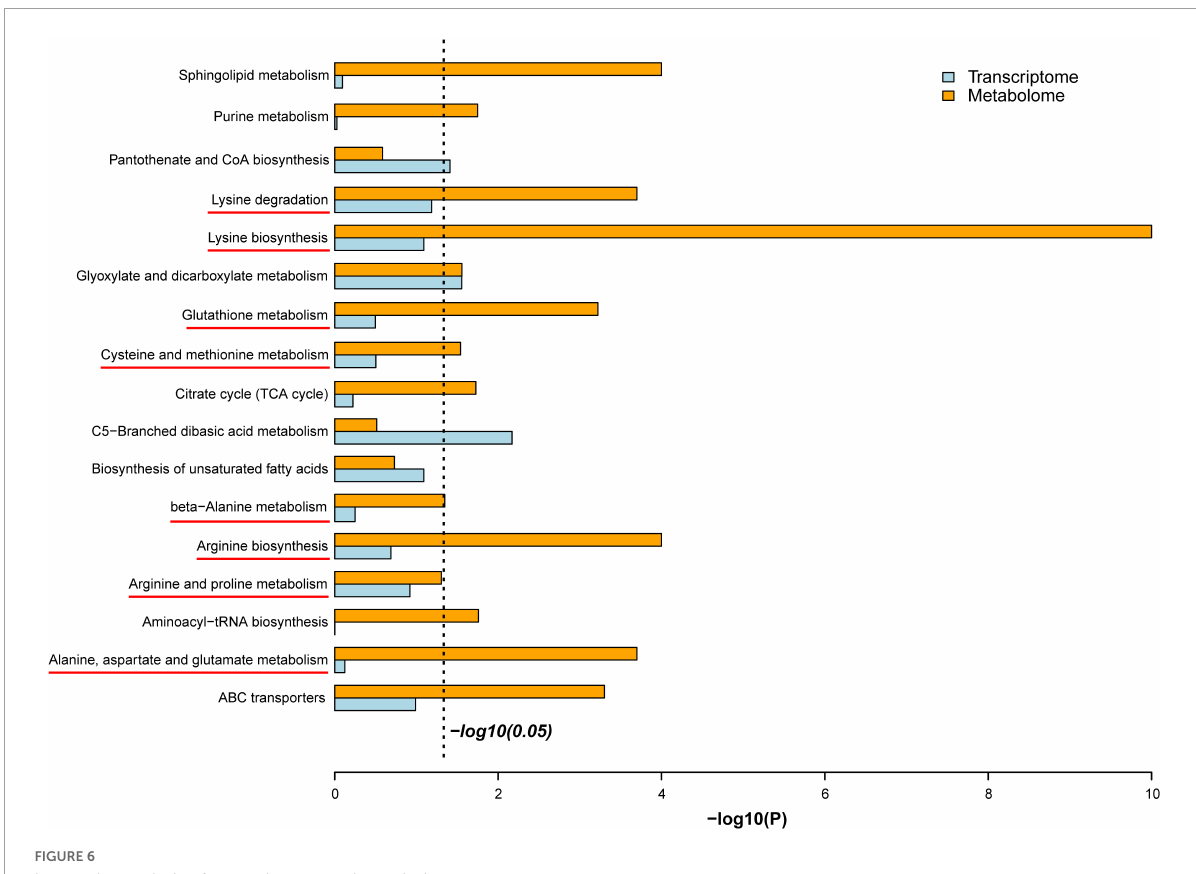
FIGURE6 Integrative analysis of transcriptome and